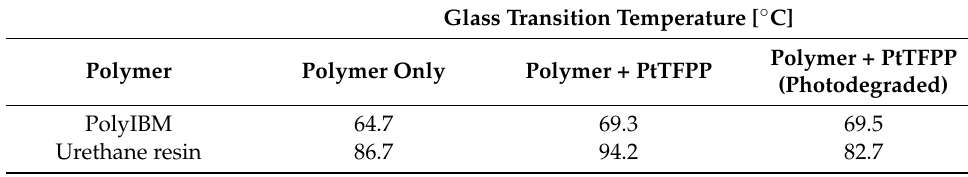
Table 2. Glass transition temperature of polyIBM and urethane